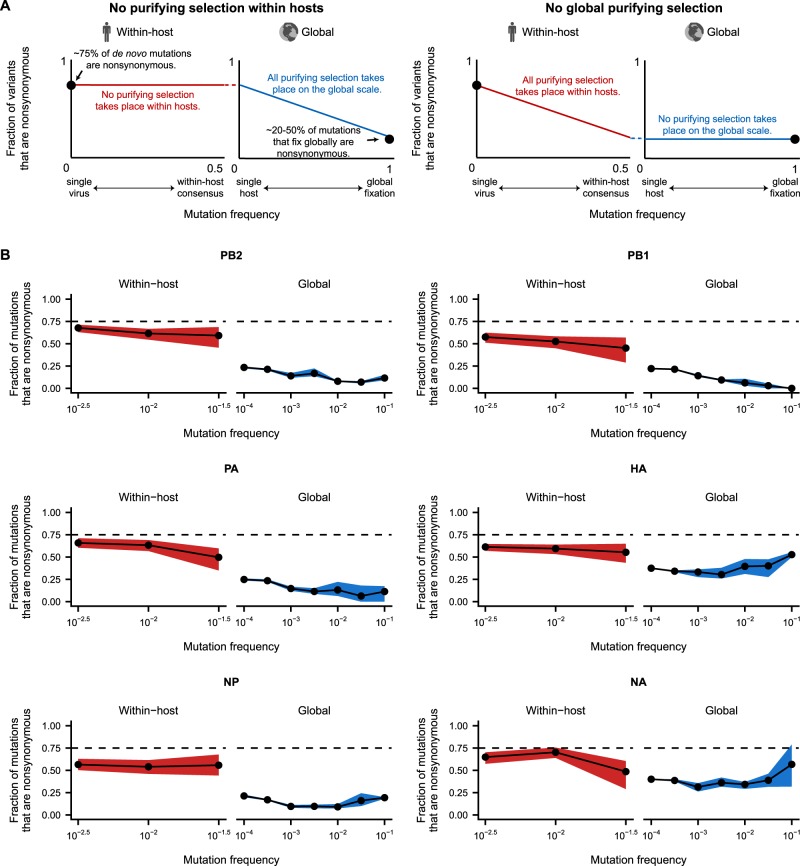
Within-host viral populations harbor many transient deleterious mutations that are purged from the global influenza population. (A) The fraction of within-host and global mutations that are nonsynonymous reveals selective pressures that act across different evolutionary scales. In the absence of selection, about 75 per cent of de novo mutations are expected to be nonsynonymous. However, only about 20–50 per cent of the mutations that fix globally are nonsynonymous, suggesting that purifying selection acts within hosts and on globally circulating mutations to remove deleterious nonsynonymous variants. These plots illustrate two scenarios for how purifying selection acts on within-host and global viral populations. (B) The fraction of within-host and global mutations that are nonsynonymous. Within-host viral populations harbor many nonsynonymous mutations, though less than would be expected in the absence of selection (dashed line). Purifying selection acts strongly at transmission and in the early stages of global evolution to lower the fraction of nonsynonymous mutations. Dashed lines indicate the ∼75 per cent of de novo mutations that are expected to be nonsynonymous. The fraction of nonsynonymous mutations within hosts is shown as the mean and 95 per cent confidence interval of 100 bootstrap samples of the within-host viral populations. The fraction of nonsynonymous mutations in the global influenza population is shown as the mean, minimum, and maximum of the values calculated separately for the 2015–6, 2016–7, and 2017–8 H3N2 seasons.